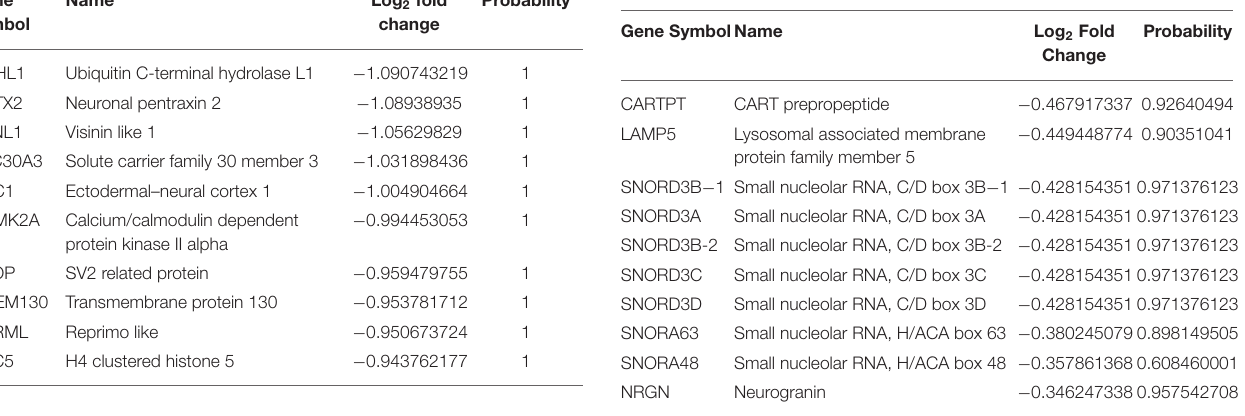
TABLE 6 | The top 10 downregulated genes in asymptomatic AD vs. control samples.